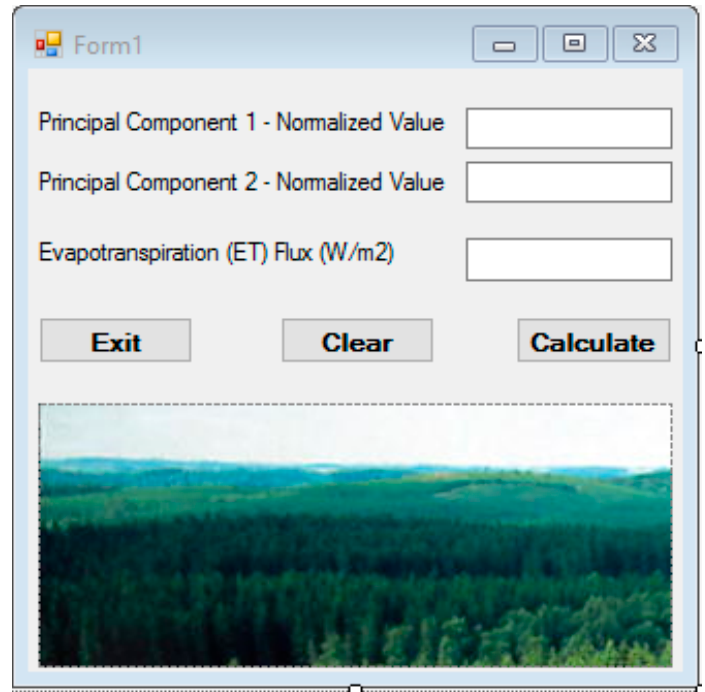
Figure A1. Form developed in VB Studio 2015. Water 2018 , 10 , x FOR PEER REVIEW